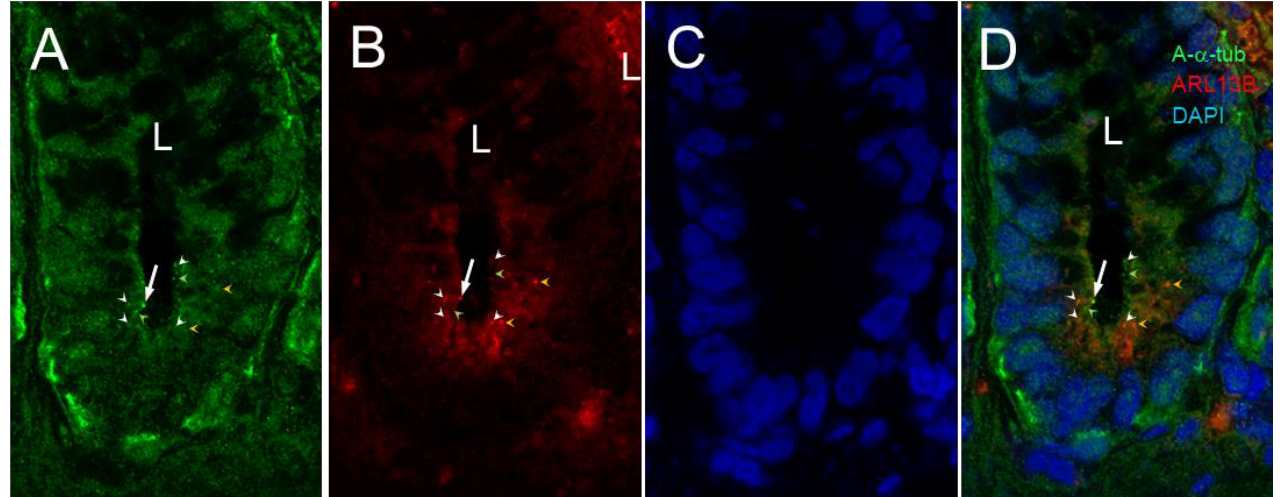
Figure 2. Primary cilia in the lower half of the crypts of the human small intestine. Representative confocal imaging for the detection of primary cilia using anti-acetylated- α -tubulin (A- α -tub; green staining, arrow in ( A , D )) and anti-ARL13B antibody (red staining, arrow in ( B , D )) in epithelial cells of the human adult small intestine (L, lumen of the crypt). Nuclei were stained with DAPI (blue) ( C , D ). Note that anti-acetylated- α -tubulin and anti-ARL13B stained smaller dots that were co-stained (white arrowheads) or not stained (green and orange arrowheads) in ( A , B , D ). Scale bar is equal to 10 µ